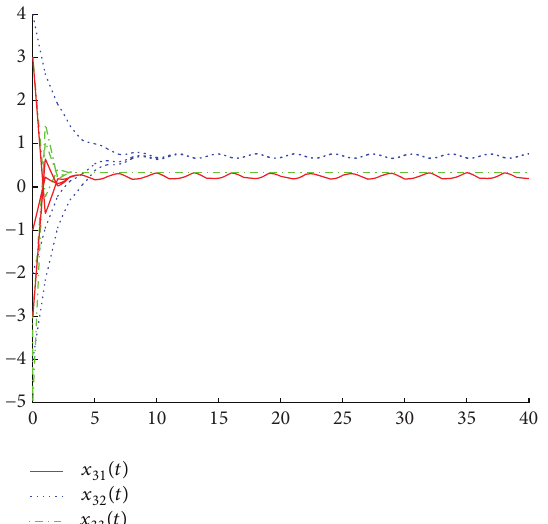
Figure 3: Numerical solutions of system (76) for different initial